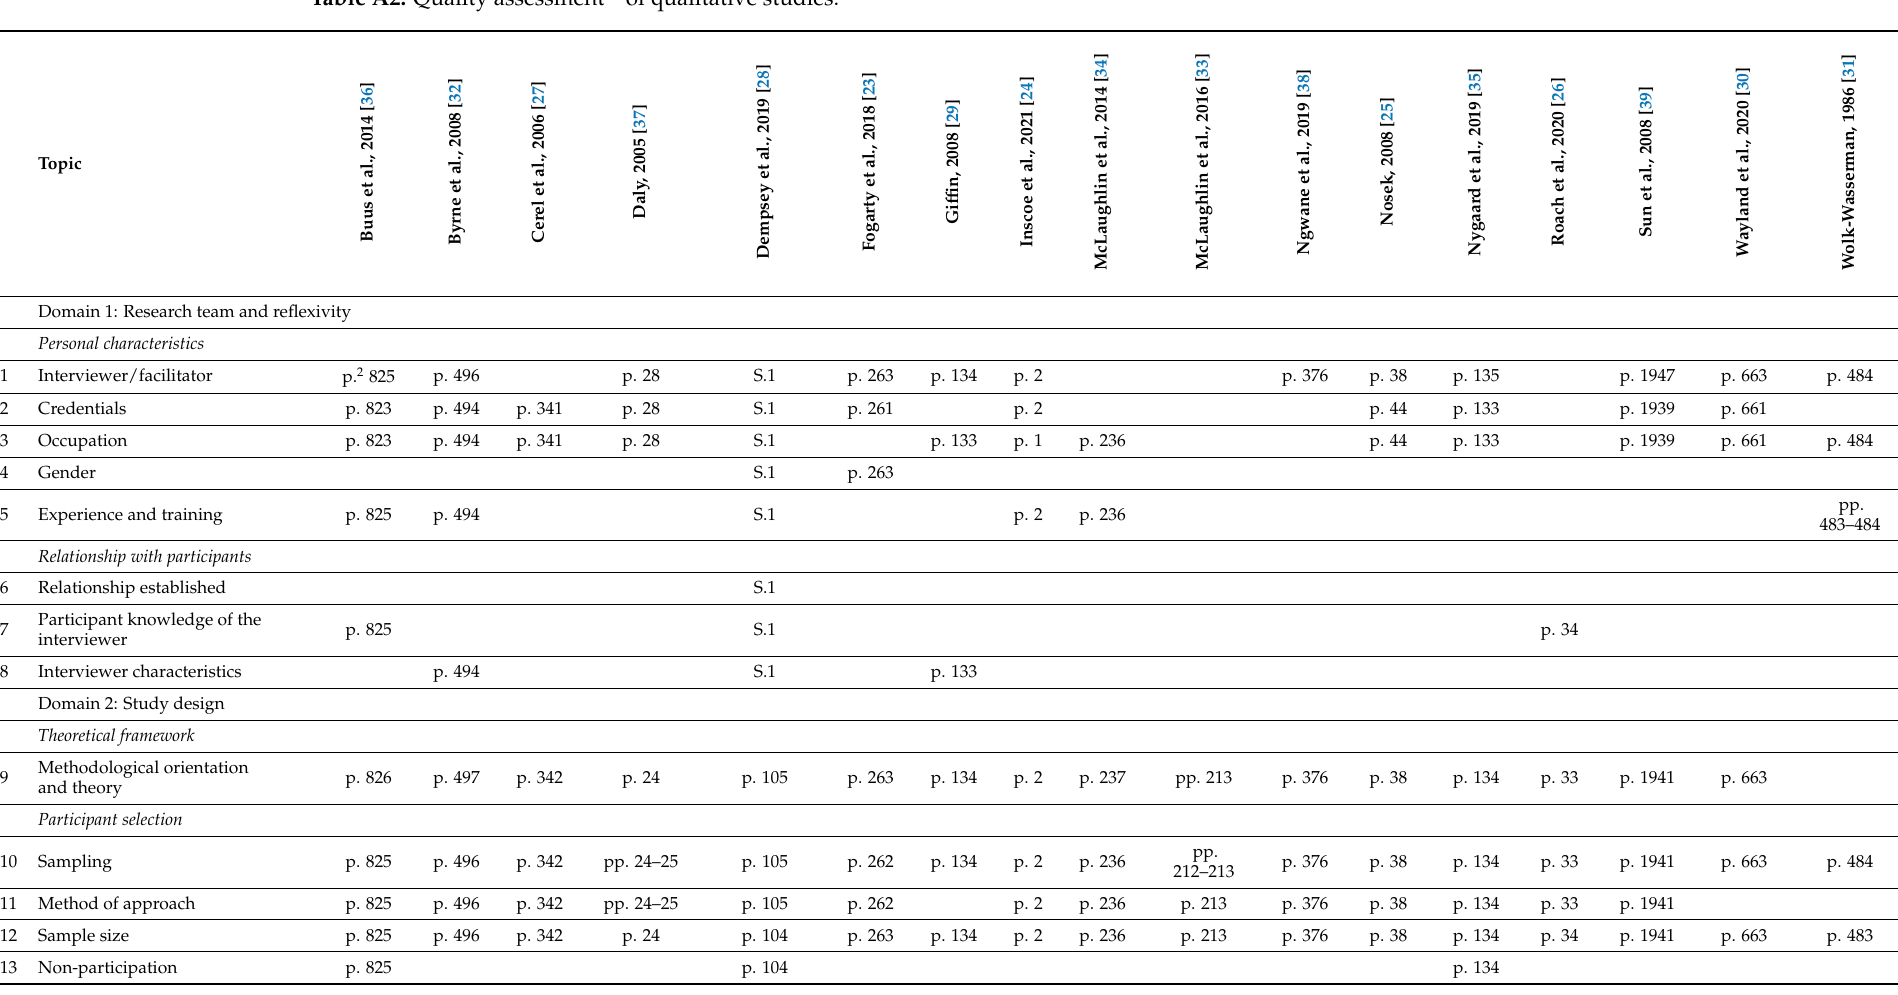
Table A2. Quality assessment 1 of qualitative